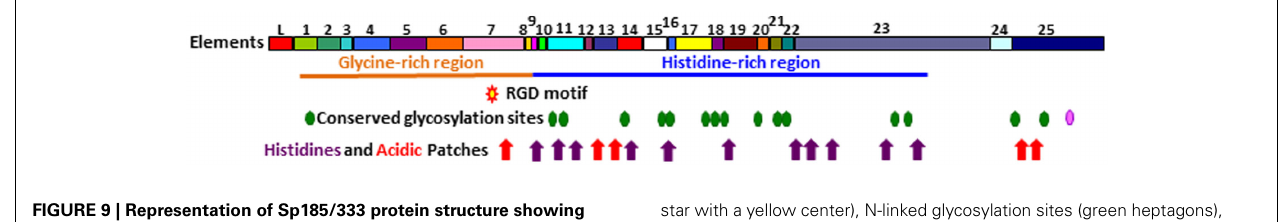
FIGURE 9 | Representation of Sp185/333 protein structure showing all possible elements. The deduced protein contains a leader (L), a glycine-rich region (orange line), and a histidine-rich region (blue line). Symbols indicate the presence of an RGD motif within element 7 (red